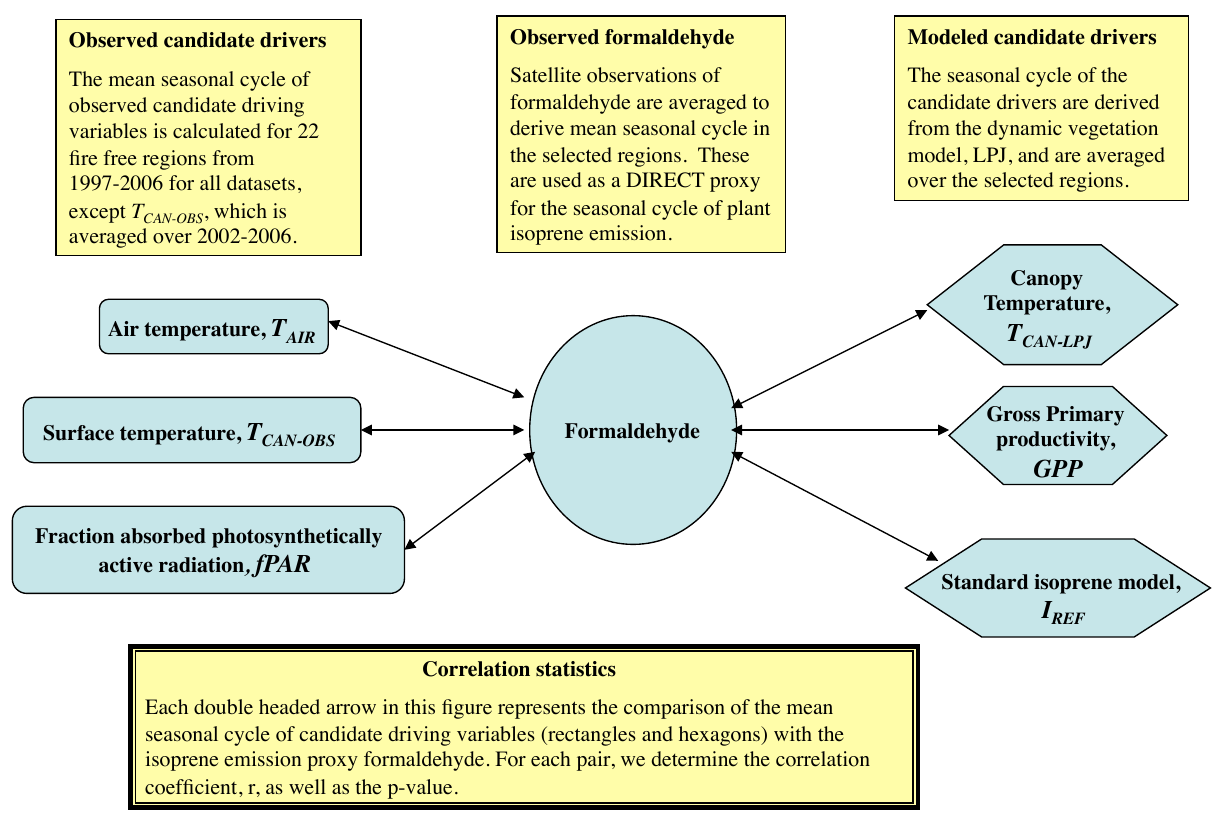
Figure 1. Schematic of the analysis. The blue boxes show variables averaged over selected regions and years to produce a mean seasonal cycle. The mean seasonal cycles of the observed and modelled variables are statistically compared with the mean seasonal cycle of satellite observations of formaldehyde – a direct proxy for plant isoprene emissions – shown in the blue circle. The “standard model” refers to the dynamic global vegetation model Lund–Potsdam–Jena (LPJ) and is based on Arneth et al.